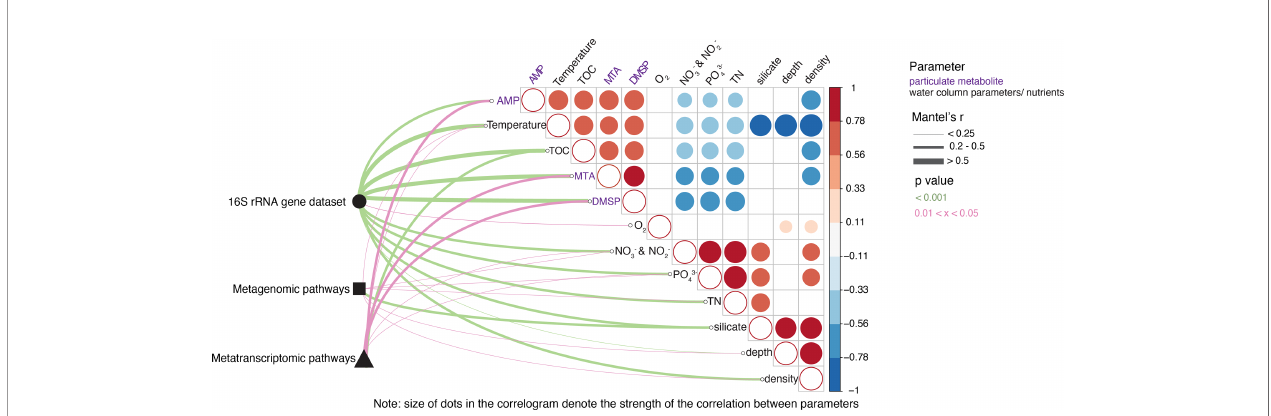
FIGURE 9 | Metabolic and environmental drivers of microbial community and metagenomic/metatranscriptomic pathways across depth and latitude. Pairwise comparisons of environmental factors (black font) and particulate metabolites (purple font) are shown as a correlogram with the color gradient denoting the strength and direction of correlation using Kendall ’ s tau. The variables shown are those that had at least one signi fi cant association with a biological dataset (16S rDNA microbial taxonomy, metagenomic or metatranscriptomic pathways) and only correlations for those water column parameter/metabolite data having signi fi cant correlations between each other are shown. Taxonomic community composition (16S rRNA gene sequenced data) and functional community compositions (metagenomic and metatranscriptomic pathways) were related to each environmental parameter/metabolite using Mantel tests between dissimilarity matrices. Line width corresponds to Mantel ’ s r statistic and line color denotes the statistical signi fi cance based on 999 permutations. Note that only signi fi cant associations are shown, and that correlations between the same parameters (i.e., density vs density) are not shown to emphasize the correlations between other